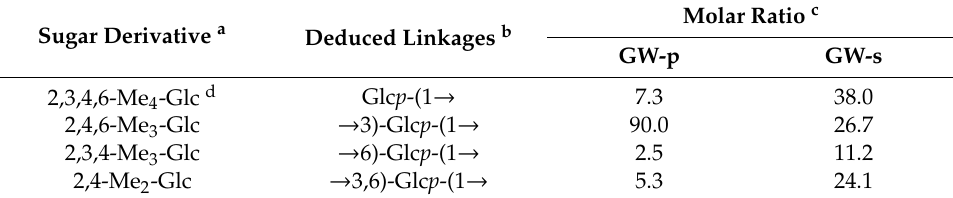
Table 3. Methylation analysis of GW-p and